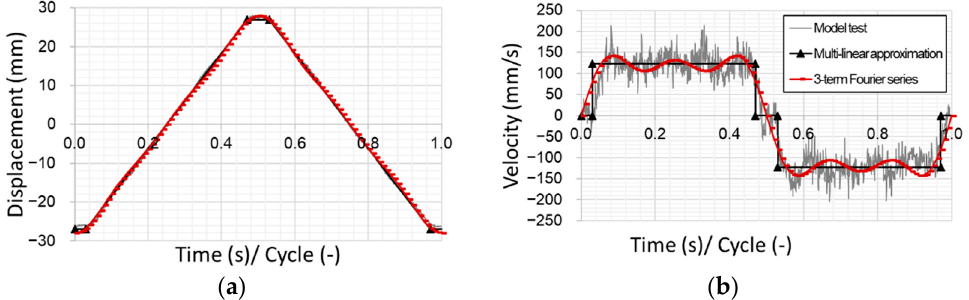
Figure 15. ( a ) Displacement and ( b ) velocity over time and for experimental test and simulation.